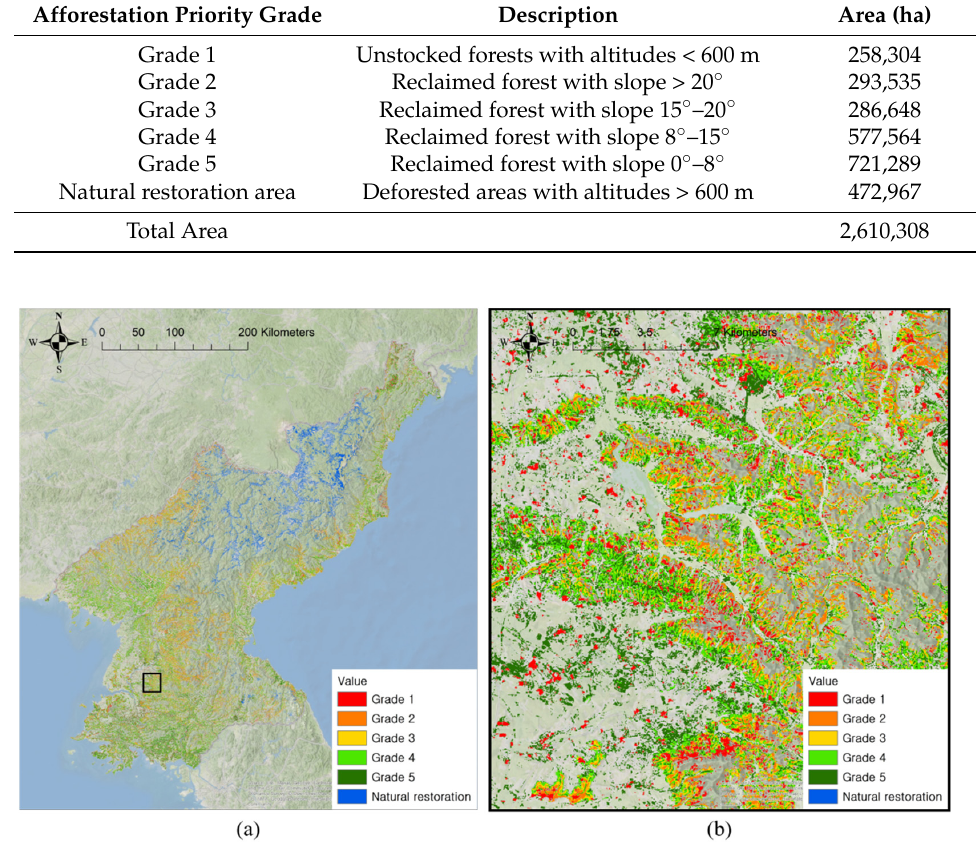
Figure 8. Mapping the afforestation priority grades in North Korea: ( a ) whole of North Korea; and ( b ) detailed view for the Pyongyang region.